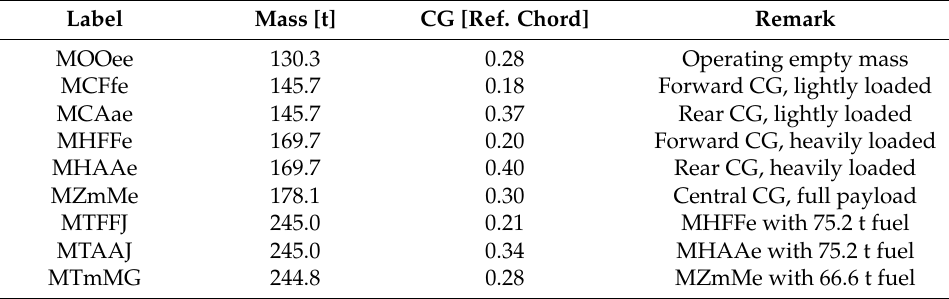
Table A1. Overview of the mass configurations.